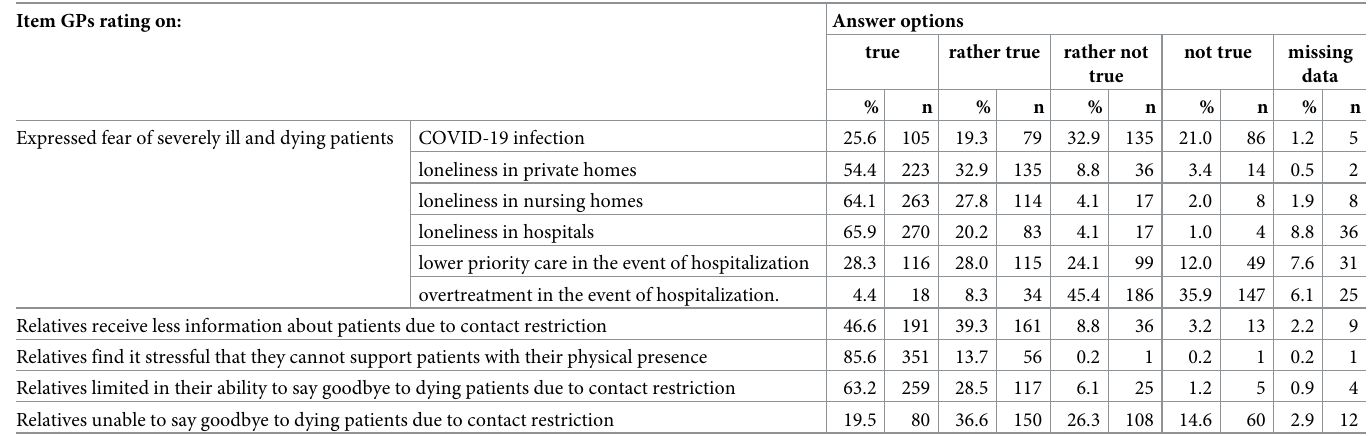
Table 4. Psychosocial aspects of severely ill and dying patients and their relatives. Item GPs rating on: